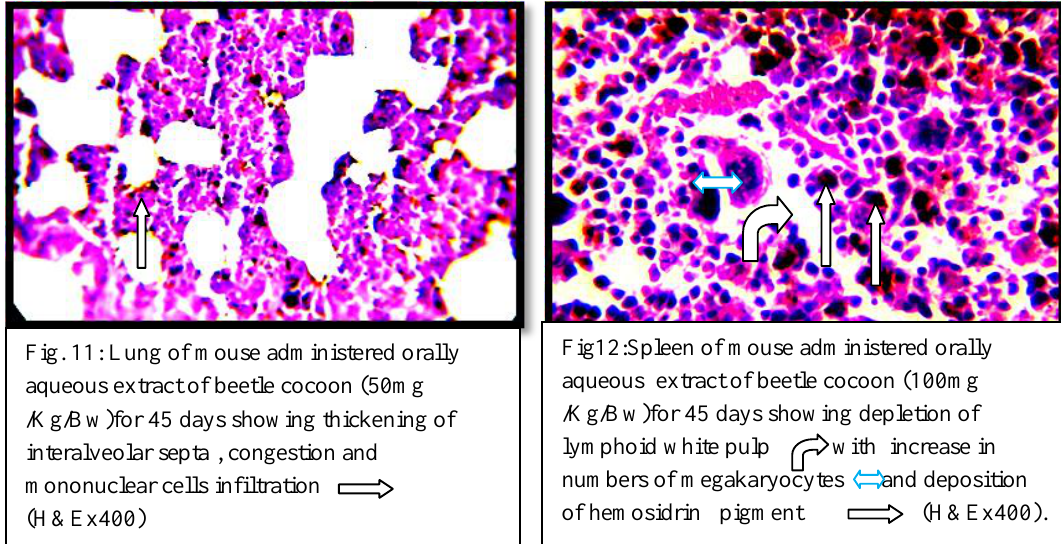
Fig12:Spleen of mouse administered orally aqueous extract of beetle cocoon (100mg /Kg/Bw)for 45 days showing depletion of lymphoid white pulp with increase in numbers of megakaryocytes and deposition of hemosidrin pigment (H&Ex400).